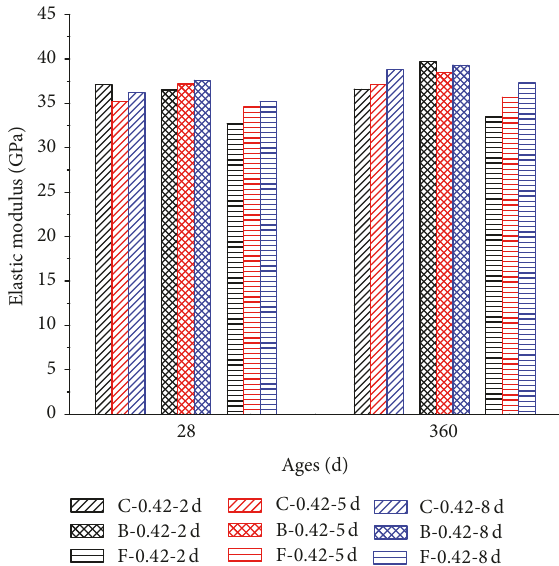
Figure 4: Nonevaporable water contents of the hydration products of binders.